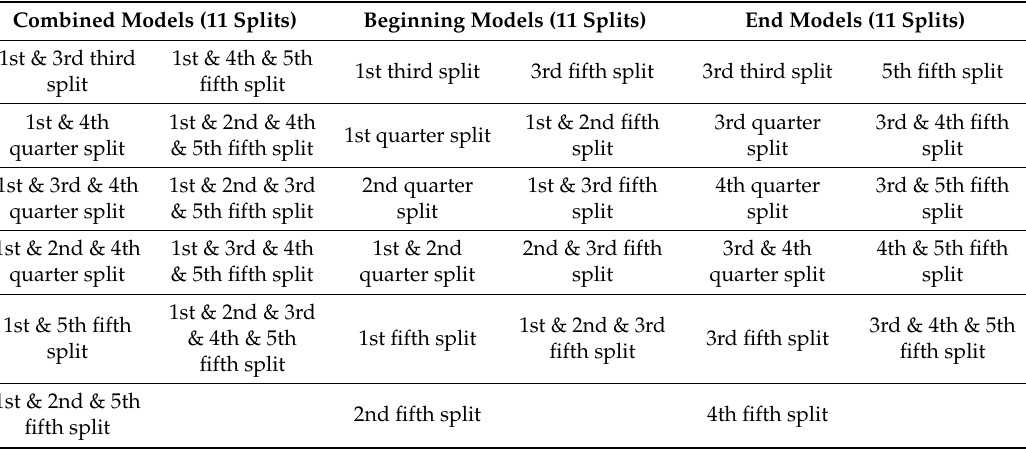
Table 2. The three categories of splits (combined models, beginning and end models) to investigate which categories are most useful. Each split is processed individually by RFc (5k trees) using FF4 and optimal